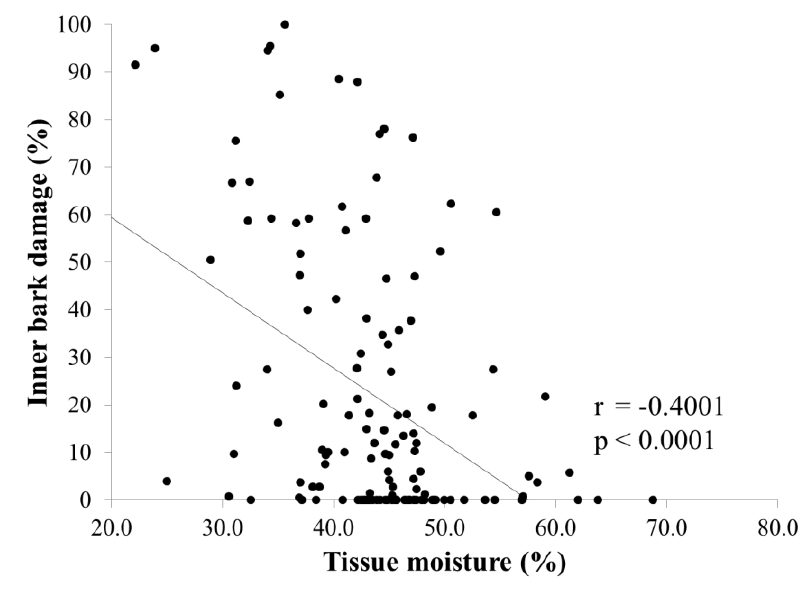
Figure 2. The pooled percentage incidence of Phoracantha semipunctata damage, the average severity of damage (% inner bark surface area damaged) and mean tissue moisture content (%) in healthy, dying and recently killed trees across 20 sites in the Northern Jarrah Forest, southwestern Australia ( n = 60). Significant differences among crown health classes were found for damage severity and tissue moisture from Kruskal–Wallis tests at alpha = 0.05. Columns sharing the same letter within a variable are not different from individual Mann–Whitney tests with Bonferroni correction. Error bars represent the standard error of the mean.